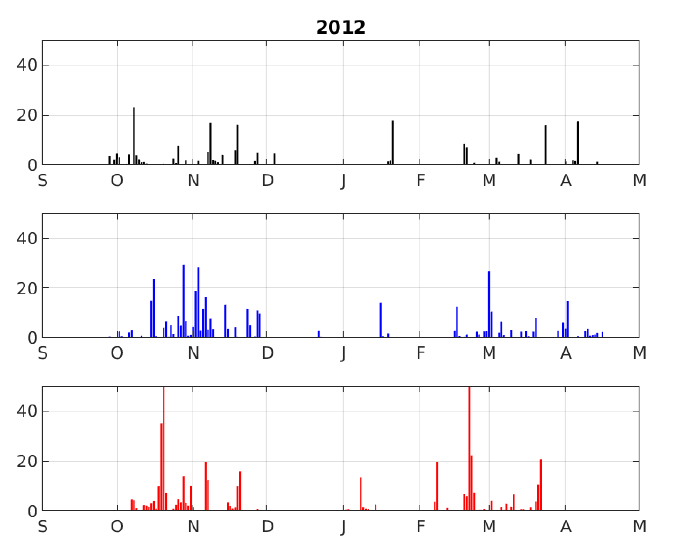
Figure 6. Example of 10-days cumulative precipitation at Oukaimeden from September 2012 to May 2013. Black: observed, blue: ERA5 and red: